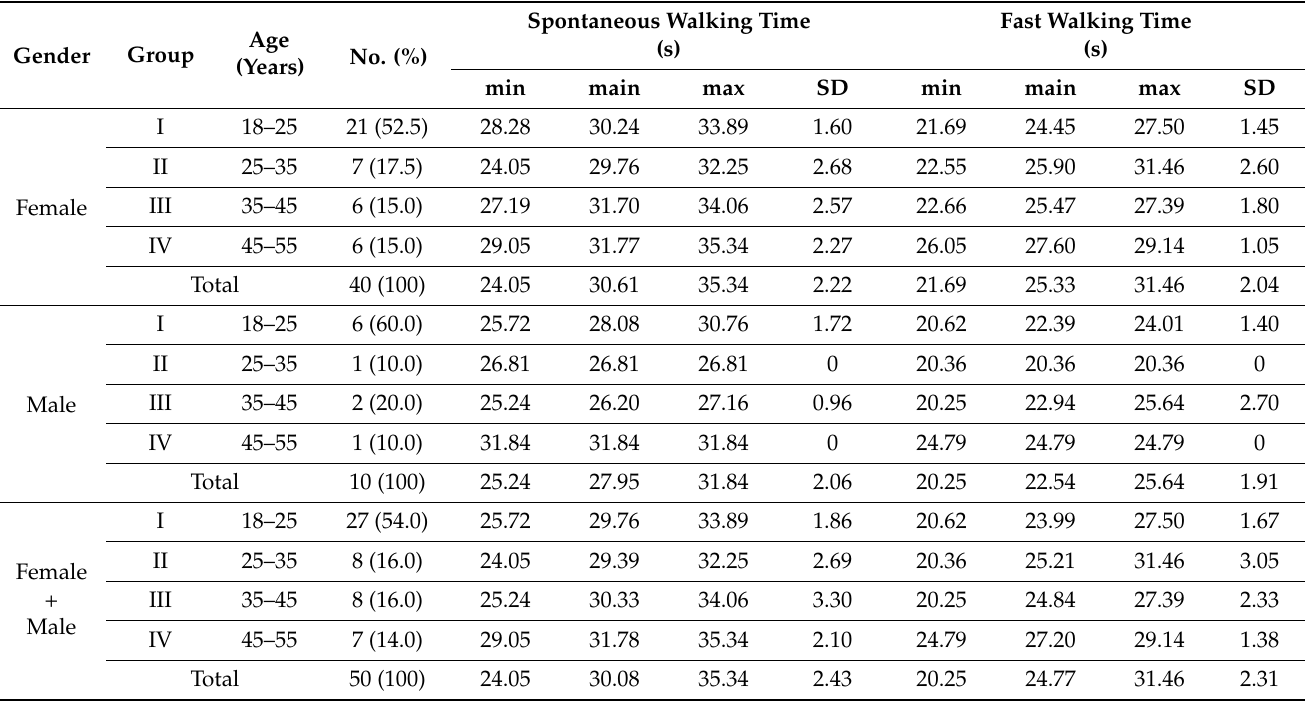
Table 2. Response time of medical staff depending on gender and age